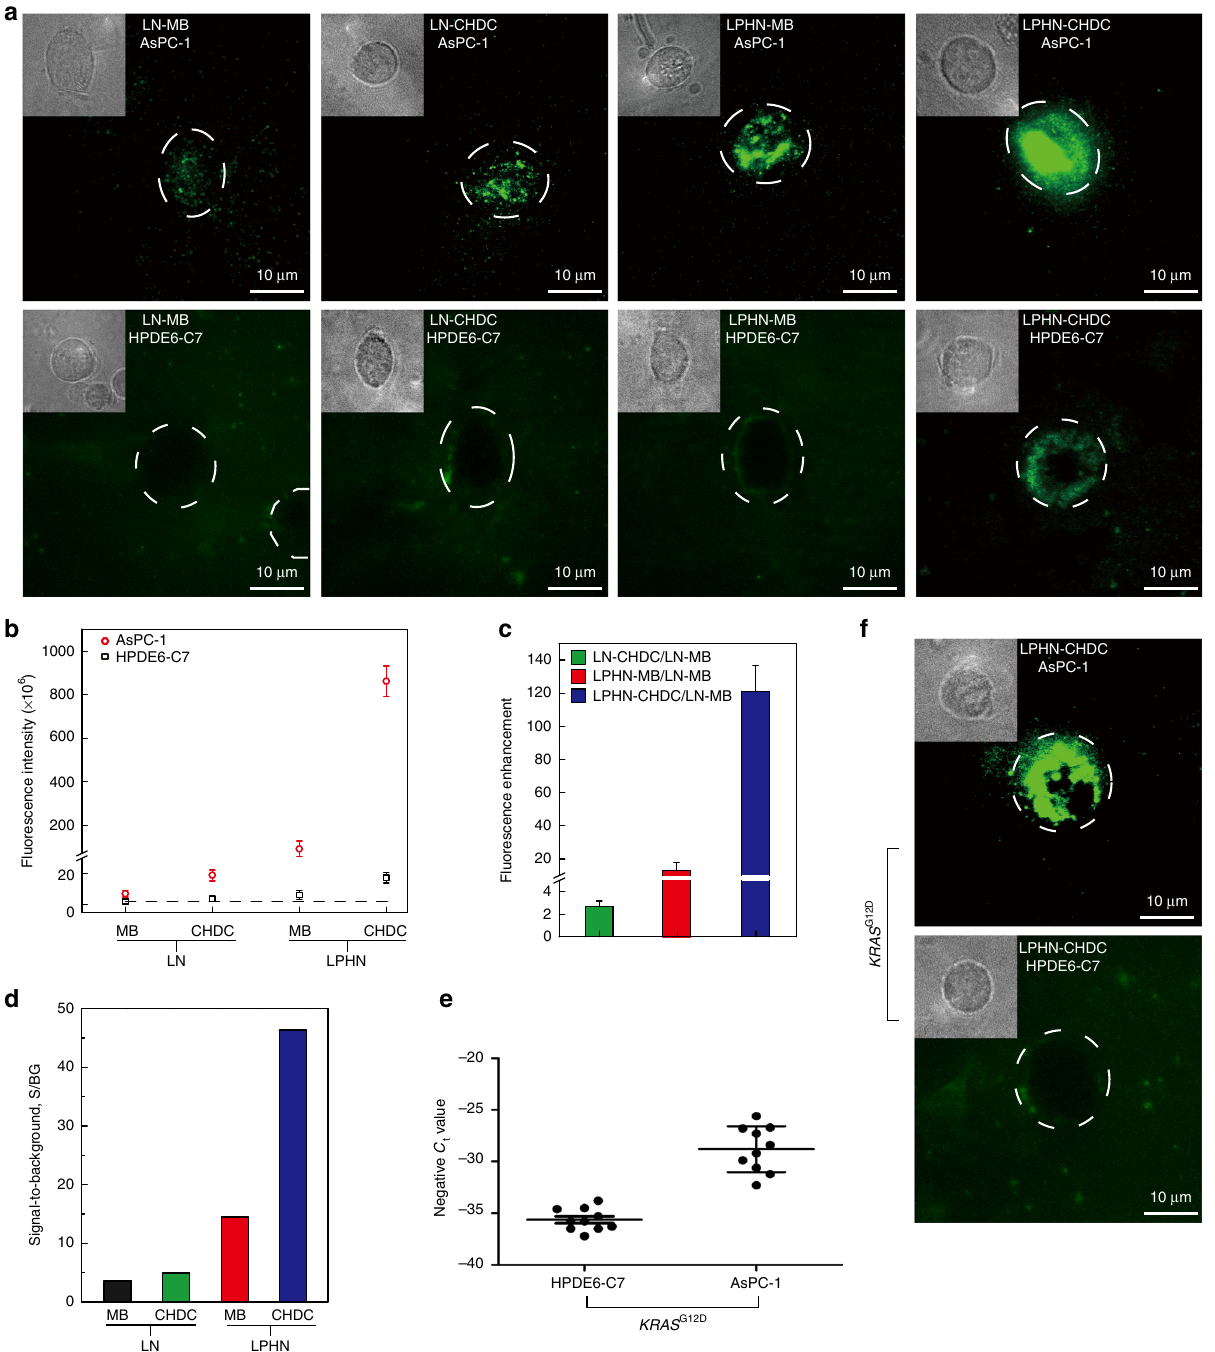
Fig. 3 Measurement of GPC1 mRNA in pancreatic AsPC-1 and HPDE6-C7 cell lines. a Representative live cell image of GPC1 mRNA in AsPC-1 and HPDE6- C7 cell lines using lipoplex nanoparticles containing molecular beacon (LN – MB), lipoplex nanoparticles containing catalyzed hairpin DNA circuit (LN – HDC), lipid-polymer hybrid nanoparticles containing molecular beacon (LPHN – MB), and lipid-polymer hybrid nanoparticles containing catalyzed hairpin DNA circuit (LPHN – CHDC), respectively (inside upper left, zoomed phase contrast image of individual cell). b Fluorescence intensity of AsPC-1 cells (signal) and HPDE6-C7 cells (control) treated with LN – MB, LN – CHDC, LPHN – MB, and LPHN – CHDC, respectively. c Fluorescence signal ampli fi cation capability of LN – CHDC, LPHN – MB, and LPHN – CHDC relative to LN – MB based on cell-associated fl uorescence of AsPC-1 cells. d Signal-to-background ratios of LN – MB, LN – CHDC, LPHN – MB, and LPHN – CHDC (signal represents fl uorescence intensity of AsPC-1 cell; background represents fl uorescence intensity of HPDE6-C7 cell). e A scale of negative C t value shown for KRAS G12D expression in AsPC-1 and HPDE6-C7 cells, where a higher number represents higher expression and vice versa. f Representative live cell image of KRAS G12D in AsPC-1 or HPDE6-C7 cell lines using LPHN – CHDC (inside upper left, zoomed phase contrast image of individual cell). Data represent mean ± s.d., n = 3, three technical